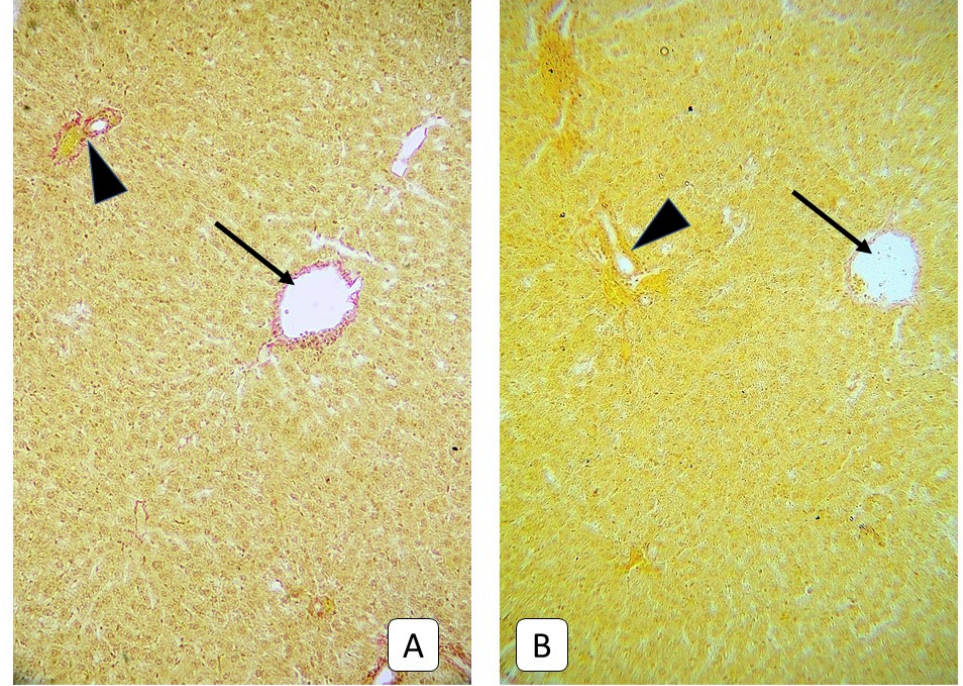
Figure 11. Photomicrograph of the liver. ( A ): juvenile rats, 21st day after mTBI. A thin layer of collagen fibers within the wall of central vein (arrow) and portal triad (arrowhead). ( B ): control group. Central vein (arrow) and portal triad (arrowhead). VanGiesone, ×400.